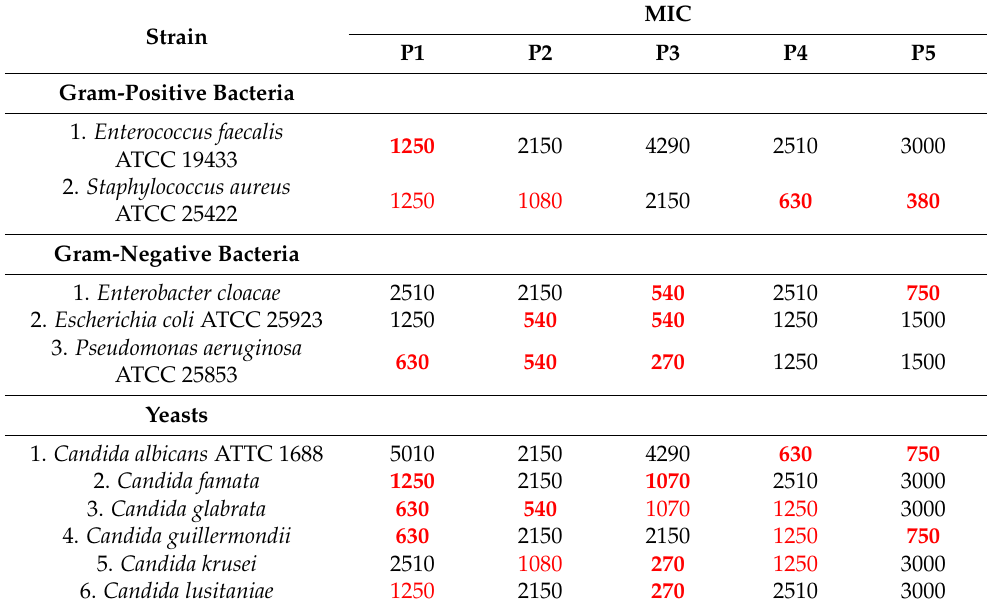
Table 7. Determination of MIC values ( µ